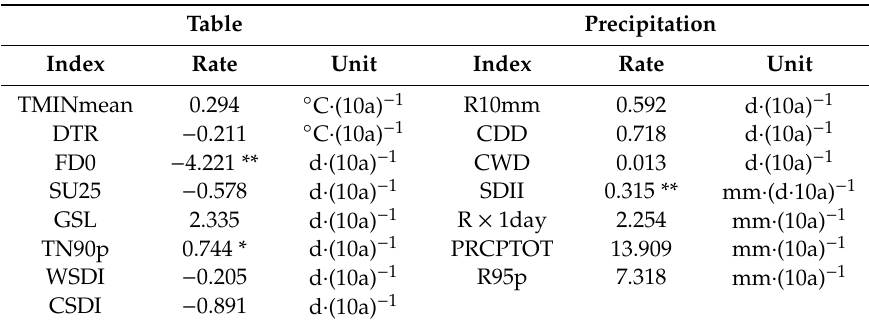
Table 2. The variation trends of the extreme climate indices.